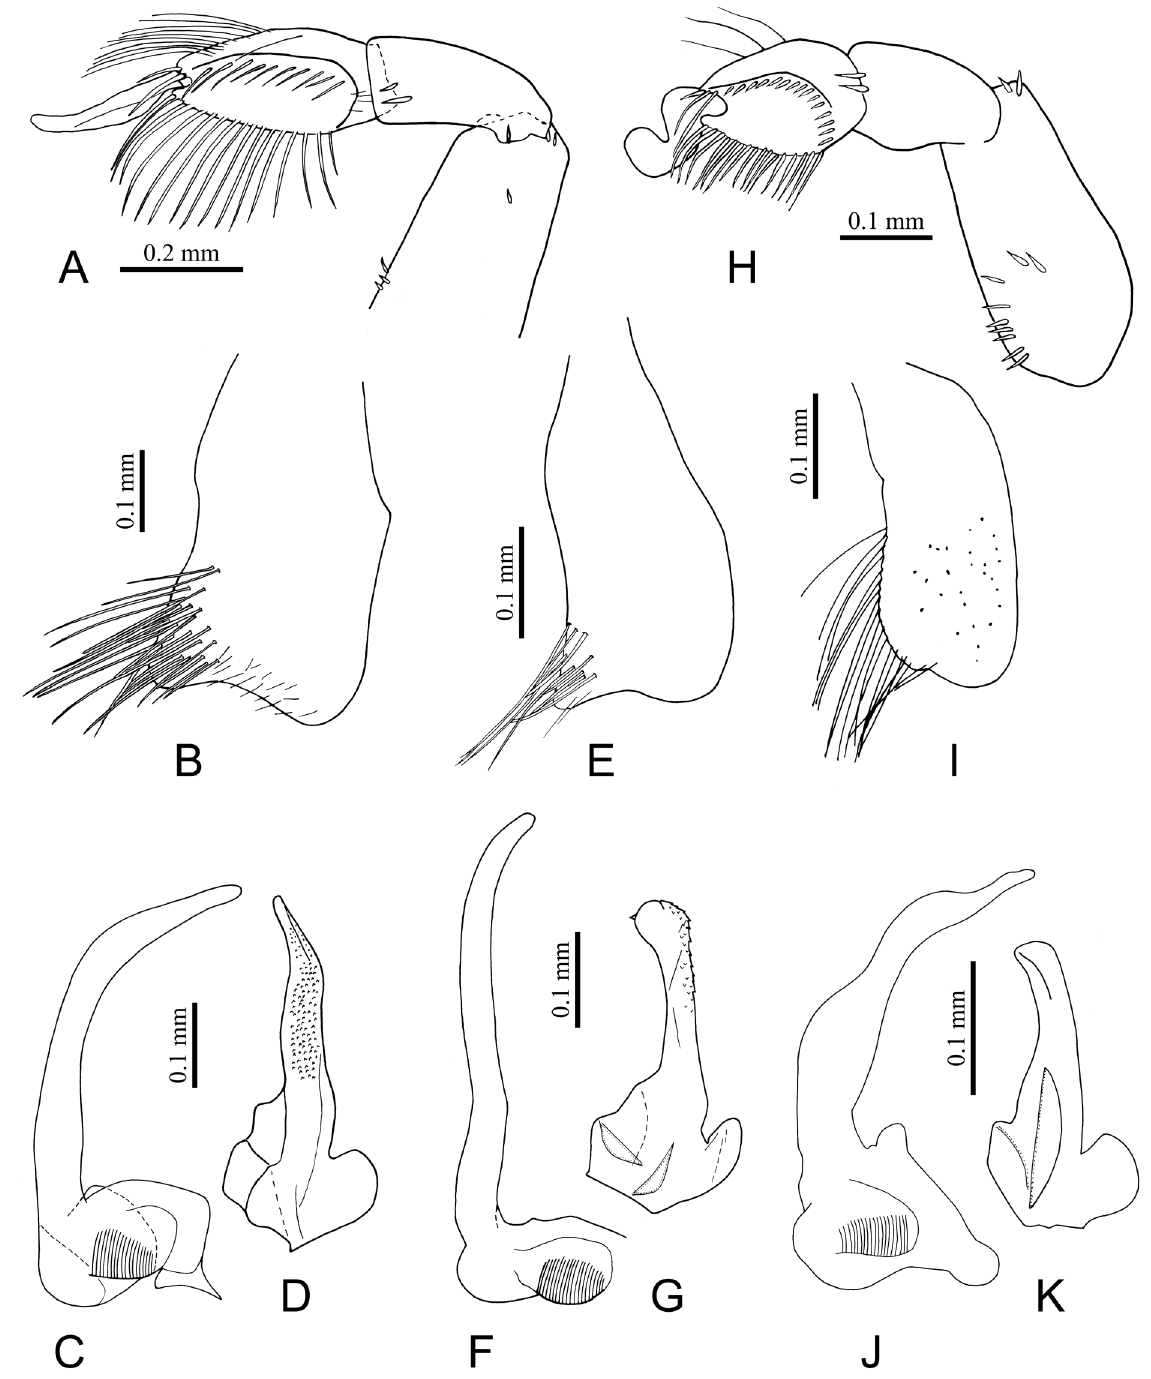
Fig. 2. Morphological features of species of Micronecta Kirkaldy, 1897, ♂♂. A–D . M . scutellaris (Stål, 1858) (ZVNU). E–G . M . sedula Horváth, 1905 (ZVNU). H–K . M. jaczewskii Wróblewski, 1962 (ZVNU). A, H = fore leg; B, E, I = free lobe; C, F, J = right paramere; D, G, K = left